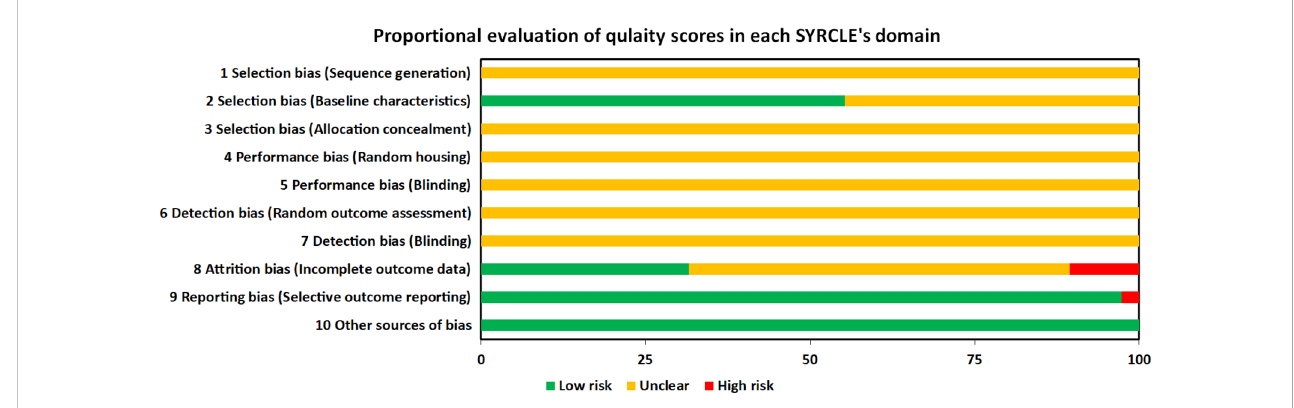
FIGURE 7 Proportional evaluation of quality score in each SYRCLE ’ s domain. SYRCLE, Systematic Review Centre for Laboratory Animal Experimentation.